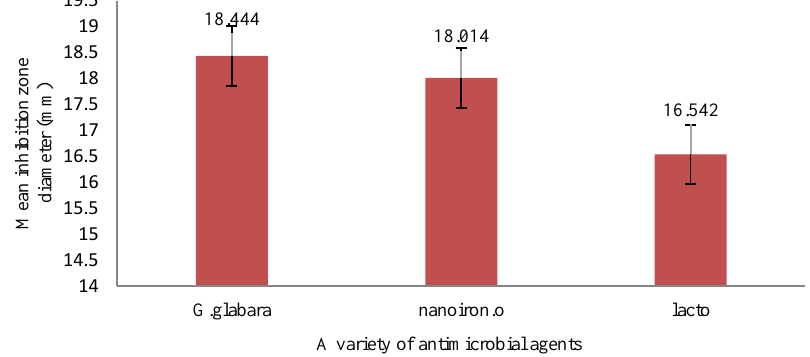
Fig. 10. Diagram of changes in mean growth inhibition zone diameter of bacterium and biofilm against different antimicrobial